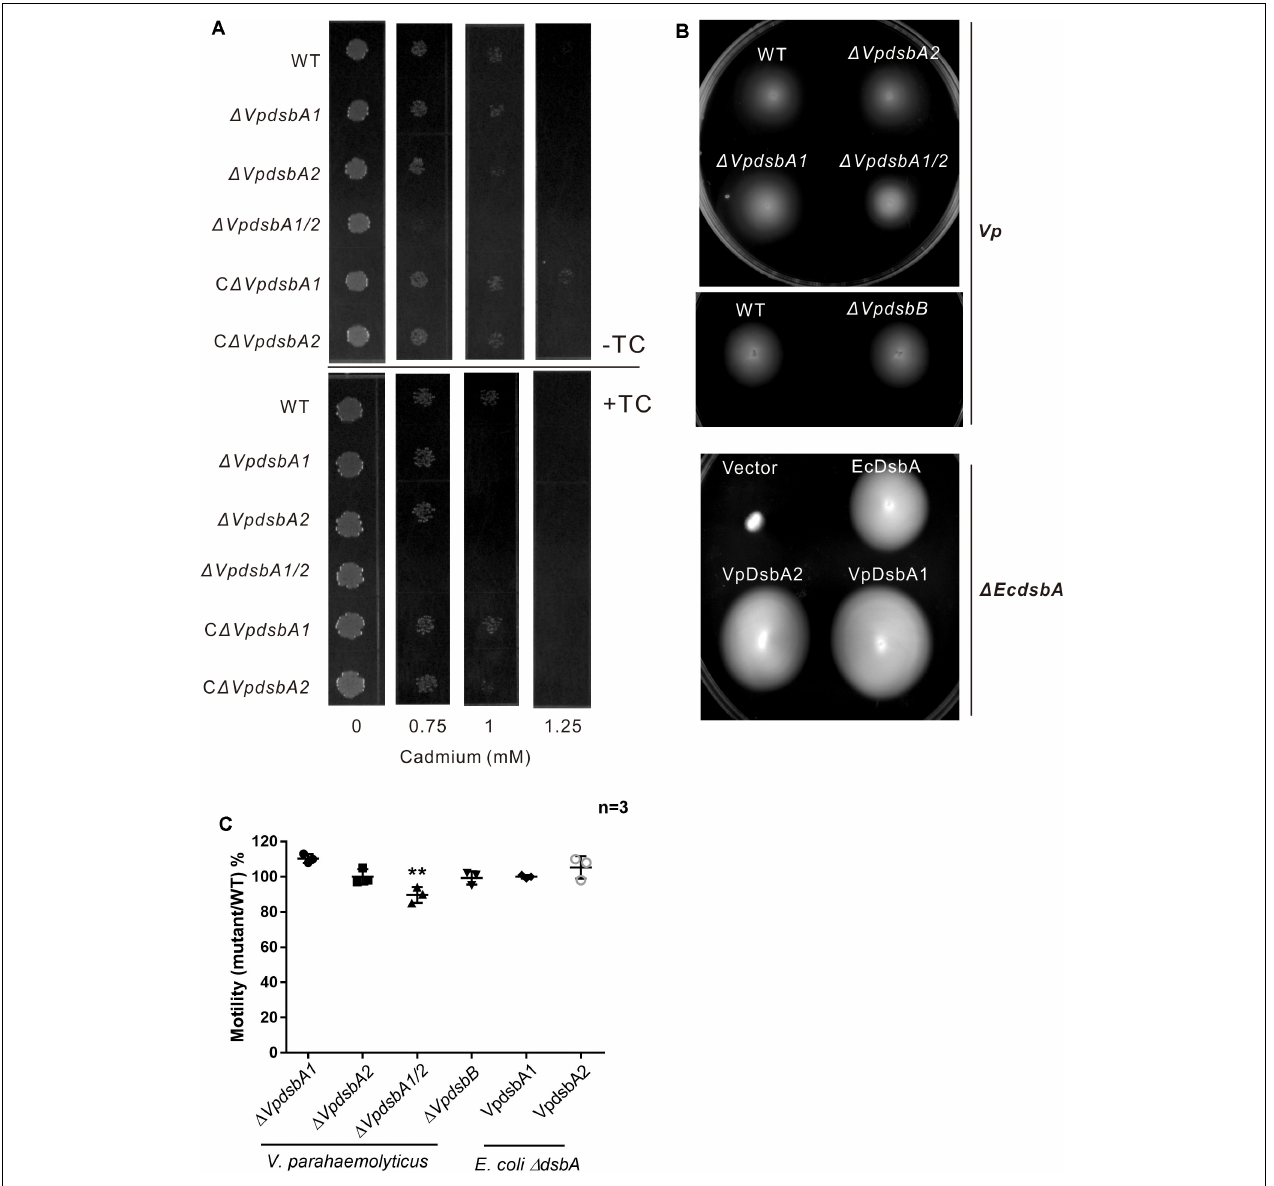
FIGURE 3 | VpDsbA in vivo activity assay. (A) V. parahaemolyticus WT, (cid:49) VpdsbA1 , (cid:49) VpdsbA2 , and (cid:49) VpdsbA1/2 strains were tested in cadmium sensitivity assays by spotting 10 3 cfu of each bacterial strain onto LB-NaCl containing increasing concentrations of cadmium (0–1.25 mM) in the presence or absence of 1 mM TC. (B) Motility assay of V. parahaemolyticus dsb mutants and E. coli (cid:49) EcdsbA complemented with either EcdsbA, VpDsbA1, or VpDsbA2. (C) Quantification of the diameter of the motility circle of each strain shown in panel (B) was performed using ImageJ software. Graph represents percentages of each V. parahaemolyticus dsb mutant versus WT strain or E. coli (cid:49) EcdsbA complemented with either VpDsbA1 or VpDsbA2 versus that with EcdsbA. Statistical analysis was calculated by one-way ANOVA. n = 3. ∗∗ P < 0.001.